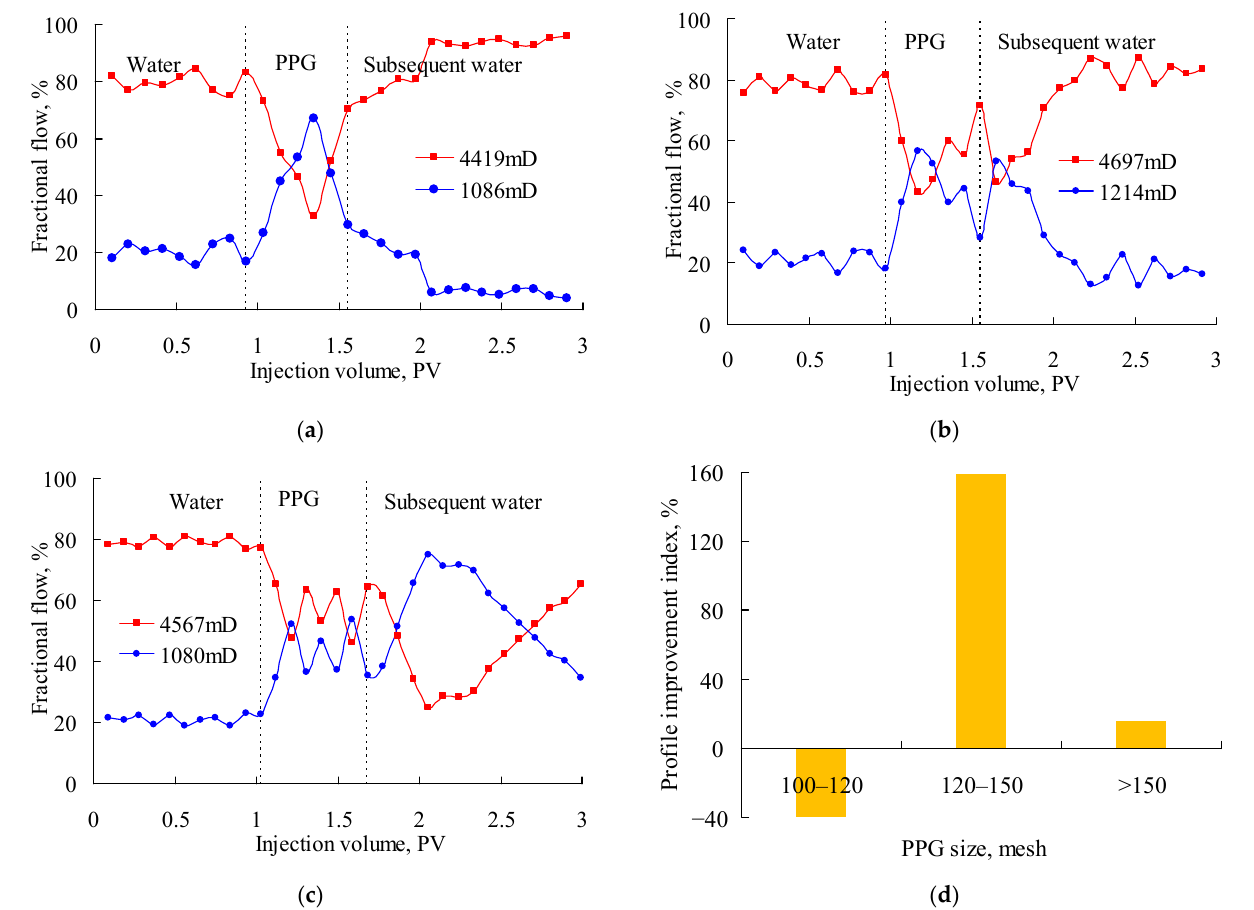
Figure 6. Fractional flow of parallel sand packs with permeability ratio of about 4 after injecting the PPG (12–16 Pa). ( a ) 100–120 mesh; ( b ) 150–180 mesh; ( c ) 120–150 mesh; ( d ) profile improvement index.